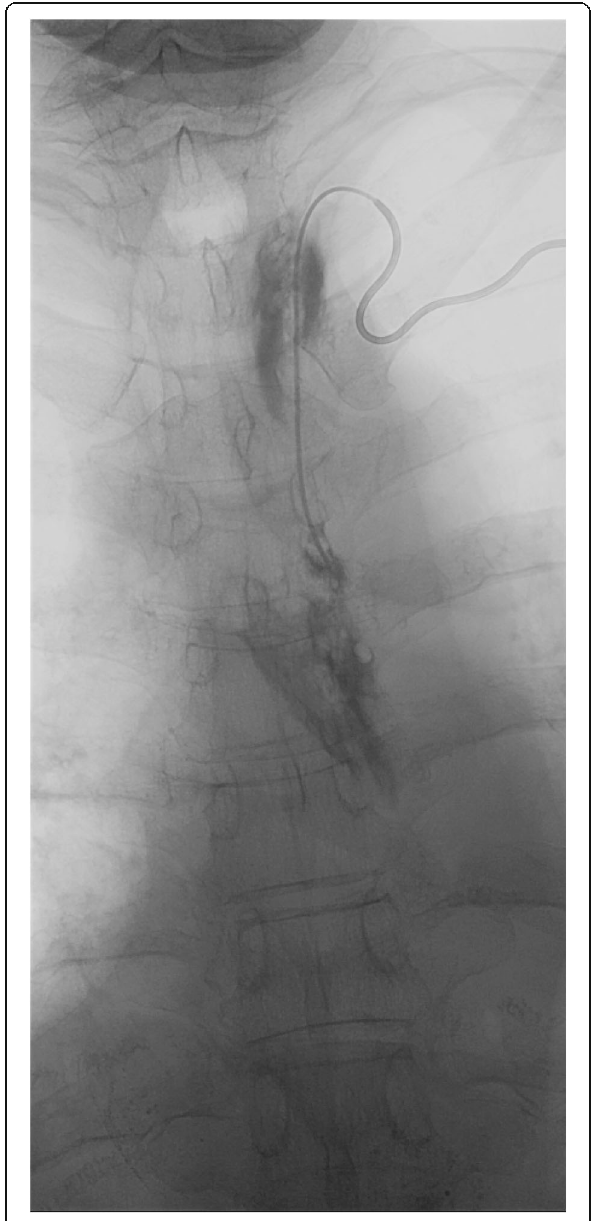
Fig. 3 Retrograde transvenous embolization of the thoracic duct. Microcatheter in the distal thoracic duct with some contrast medium extravasation in the upper mediastinum due to slight damages of the thoracic duct with the